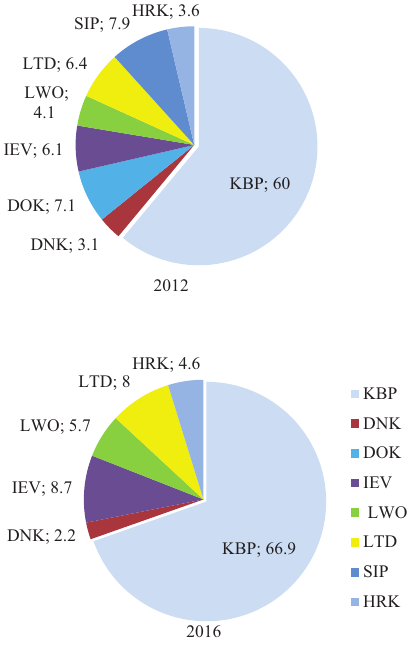
Figure 12. Market shares in the total volume of